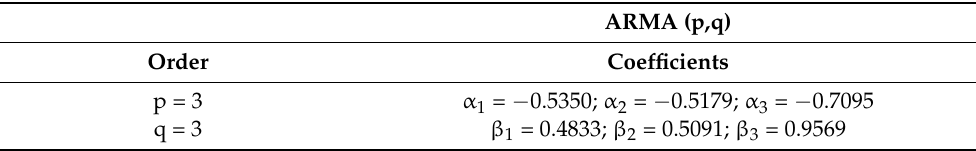
Table 1. Parameters of the ARMA model (winter day).